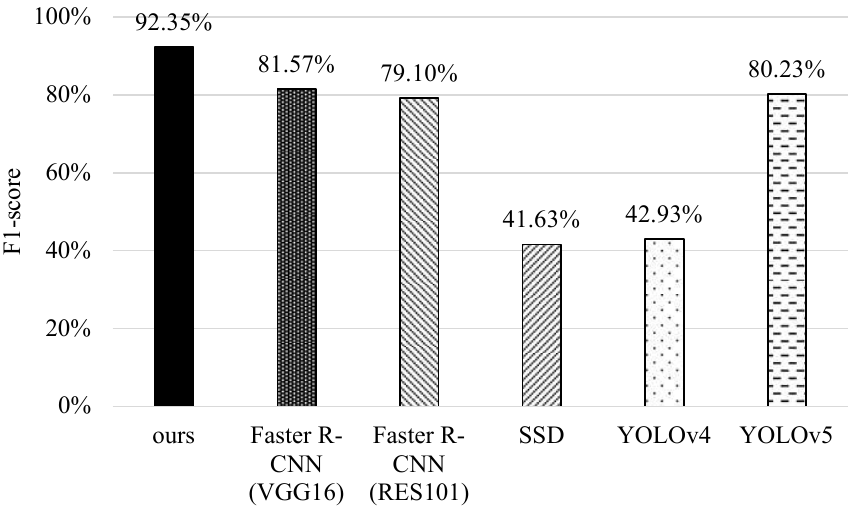
Figure 15. Comparisons of F1-scores of different methods.